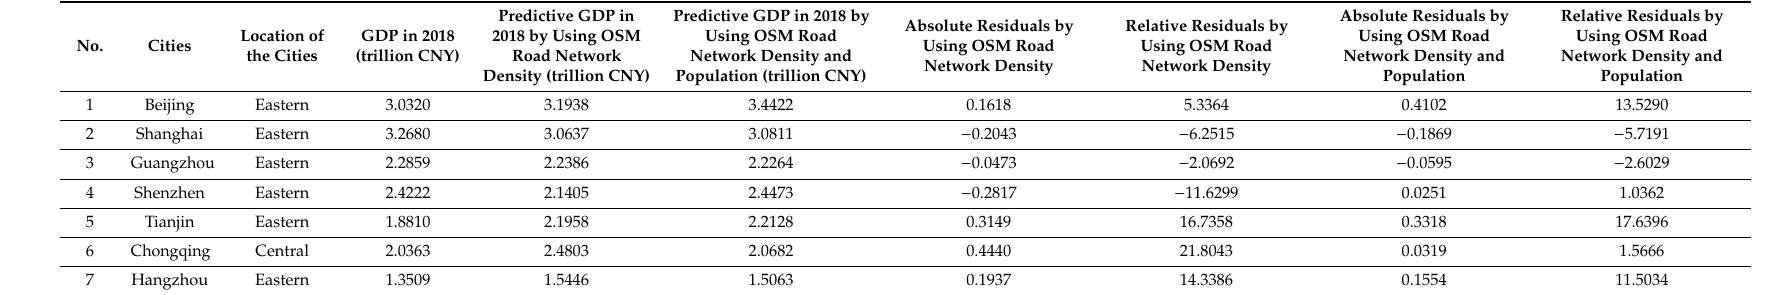
Table A2. The statistical results for predictive GDP of 85 Chinese cities in